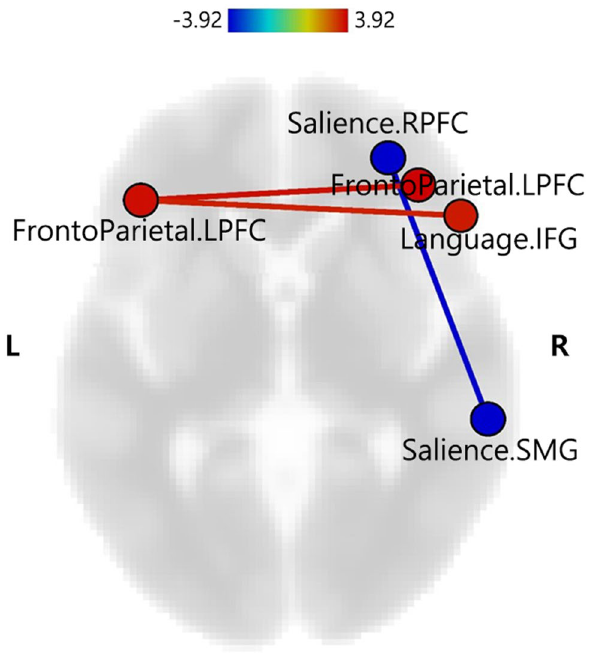
Figure 2. Significant group differences in ROI-to-ROI FC between two groups. Red lines indicate connections with increased functional connectivity in the preterm group, and the blue line indicates the connection with decreased functional connectivity in the preterm group compared to the term group. The results are presented at a threshold FDR of P < 0.05, with two-sided seed level correction. The color bar indicates the statistical t- value. FC, functional connectivity; IFG, inferior frontal gyrus; L, left; LPFC, lateral pre-frontal cortex; R, right; ROI, region of interest; RPFC, rostral pre-frontal cortex; SMG, supramarginal gyrus.